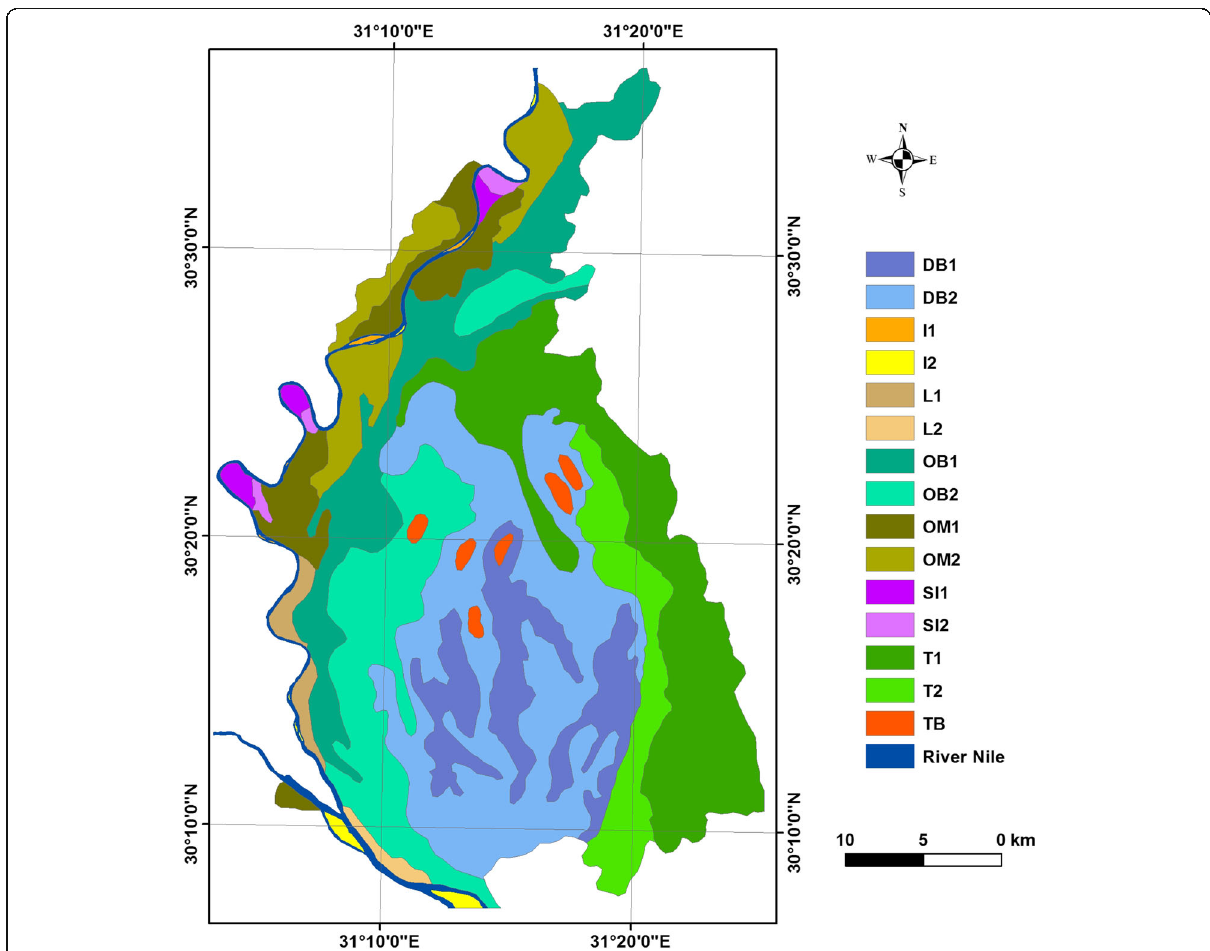
Fig. 3 Physiography and soil map of Qalyubia